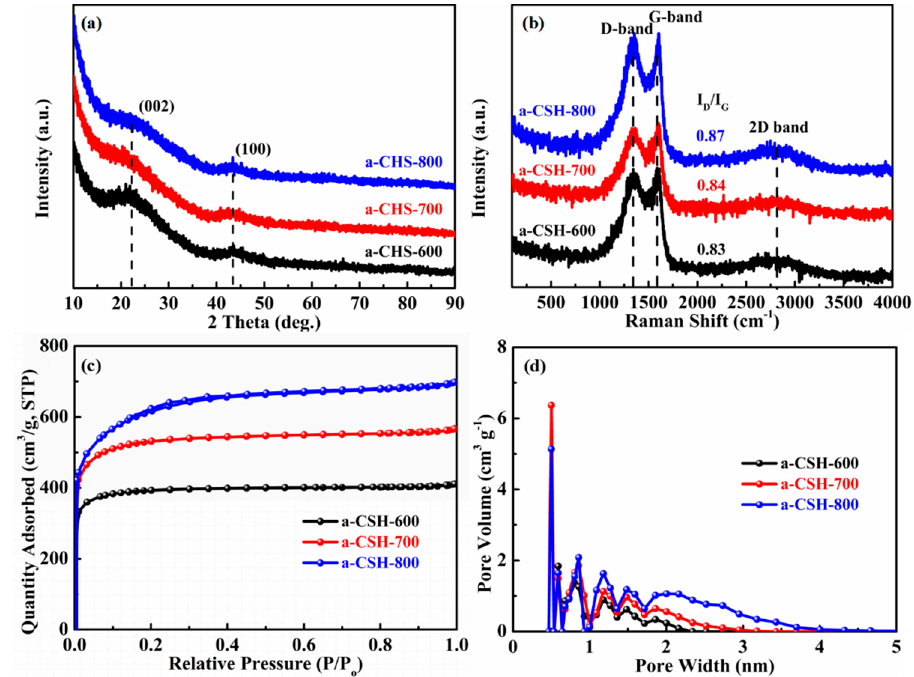
Figure 4. Powder X-ray diffraction (XRD) patterns ( a ) and Raman spectra ( b ) of a-CSHs samples. ( c ) Nitrogen adsorption-desorption isotherms and ( d ) pore size distributions of a-CSHs.